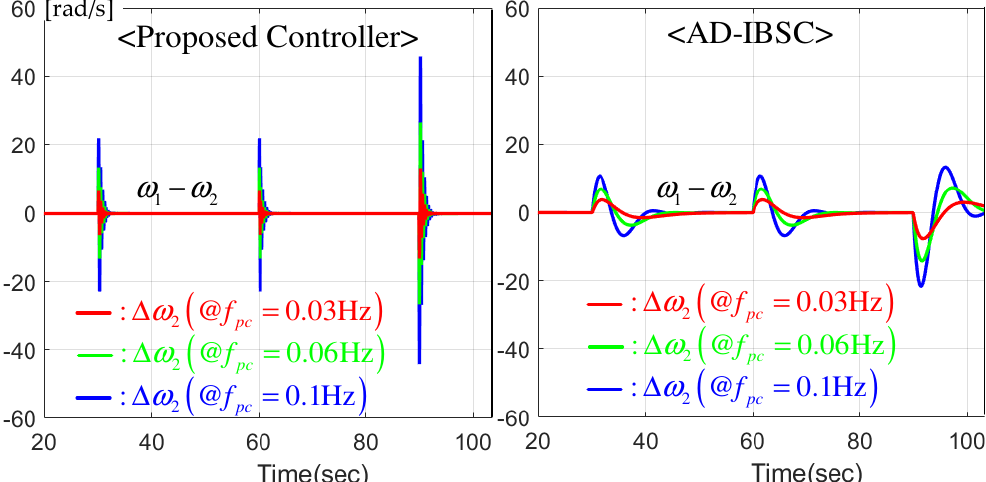
Figure 6. Speed synchronization error comparison (slave motor) for different outer loop cut-off